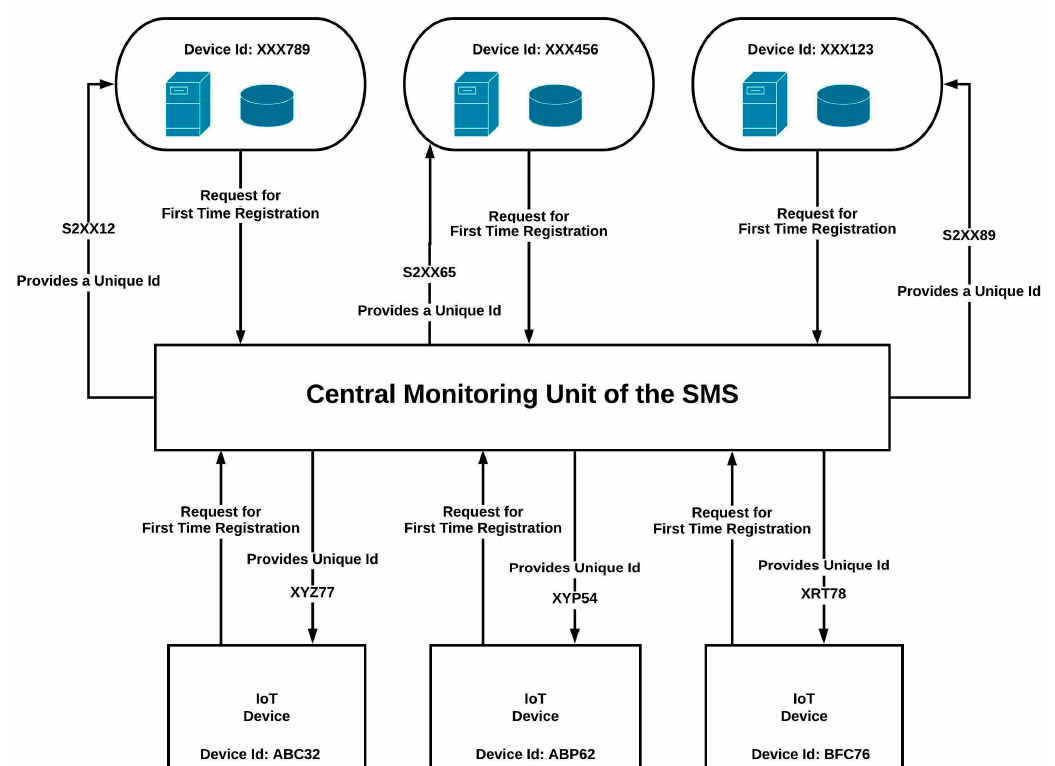
Figure 4. Creation of unique key in SMS.